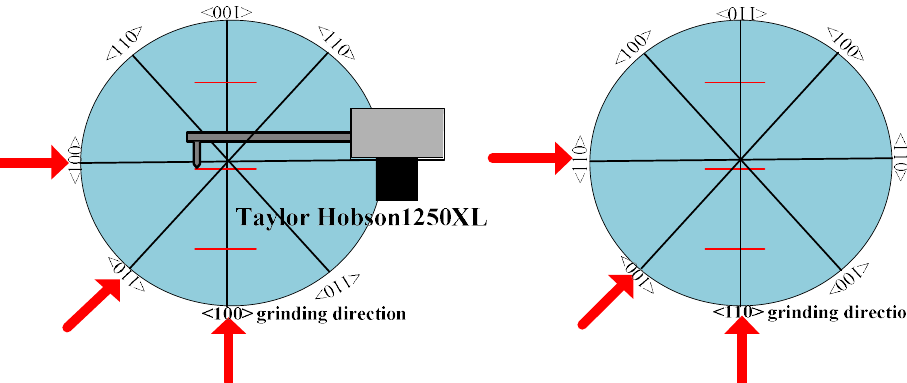
Figure 2. Measurement of the surface roughness of ground samples.